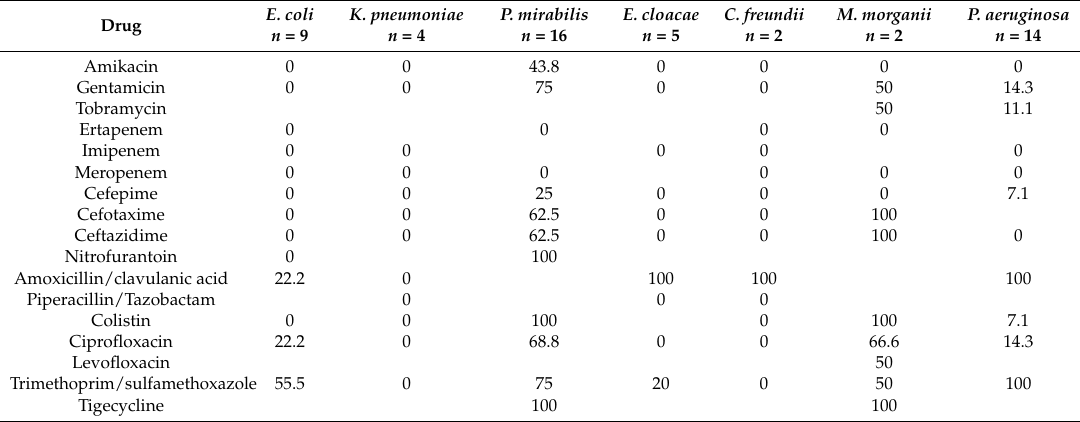
Table 1. Antibiotic resistance pattern of Gram-negative bacilli not MDR (% of resistance). n represents the number of samples. Blank: data not available.